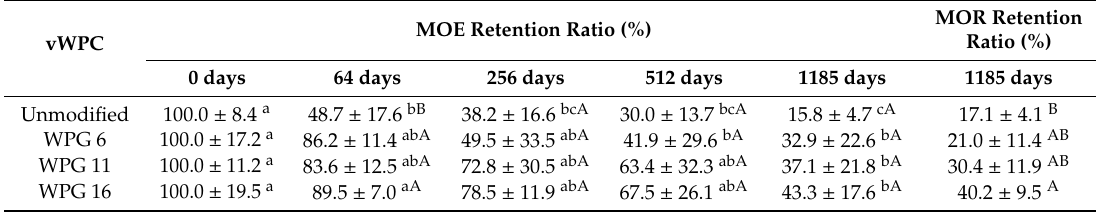
Table 2. E ff ect of acetylated veneer on MOE and MOR retention ratio of vWPCs after natural weathering for 1185 days.